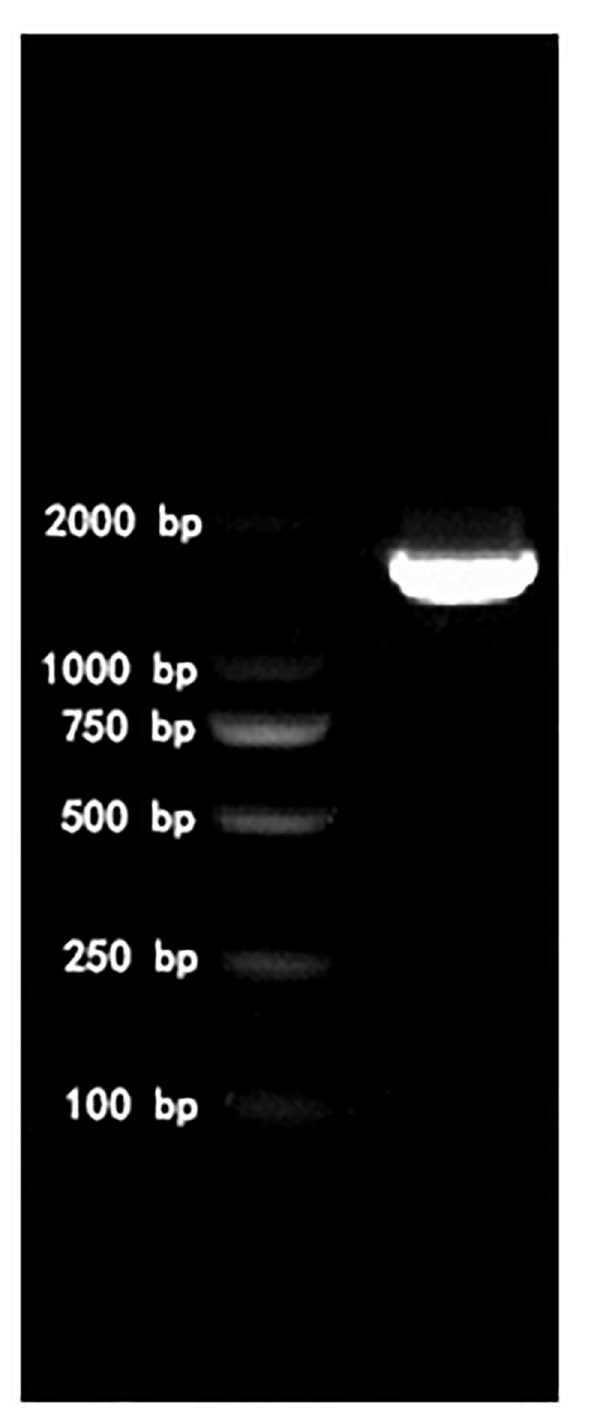
Fig 1. Agarose gel electrophoresis of C . sartagoforme XN-T4 16S rDNA.